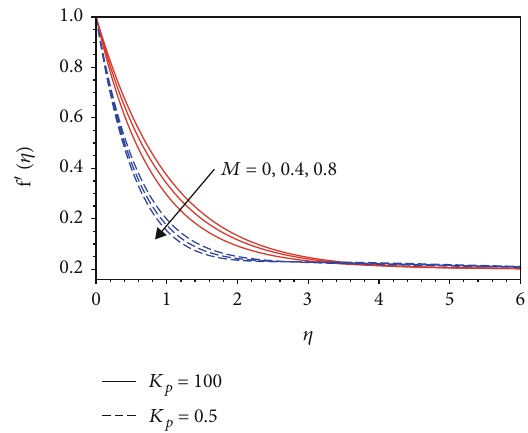
Figure 3: Velocity pro fi le for dissimilar values of M when Rc = 0 : 2, f = E = 0 . 1 w